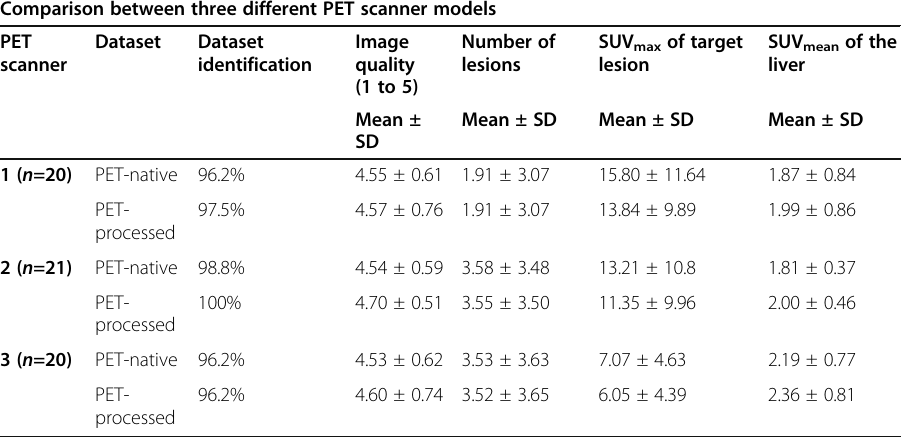
Table 5 Image quality assessment, lesion detectability, and SUV values for three different PET scanner models Comparison between three different PET scanner